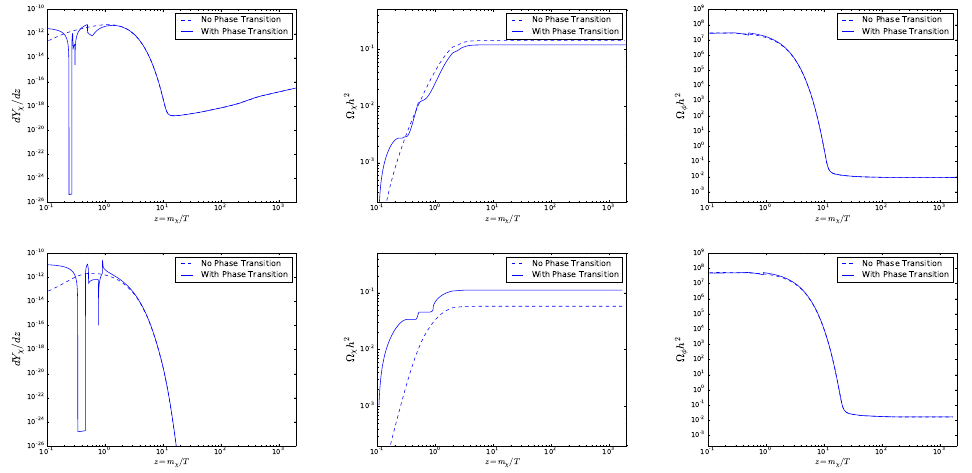
Figure 7 . The thermal corrected evolution of the number density of (cid:31) and (cid:30) for the case of m (cid:30) > m (cid:31) + m N ( m (cid:30) = 110 GeV, m (cid:31) = 50 GeV, and m N = 20 GeV, y D = 2 : 8 (cid:2) 10 (cid:0) 12 ), and m (cid:30) < m (cid:31) + m N ( m (cid:30) = 110 GeV, m (cid:31) = 90 GeV, and m N = 40 GeV, y D = 7 : 3 (cid:2) 10 (cid:0) 12